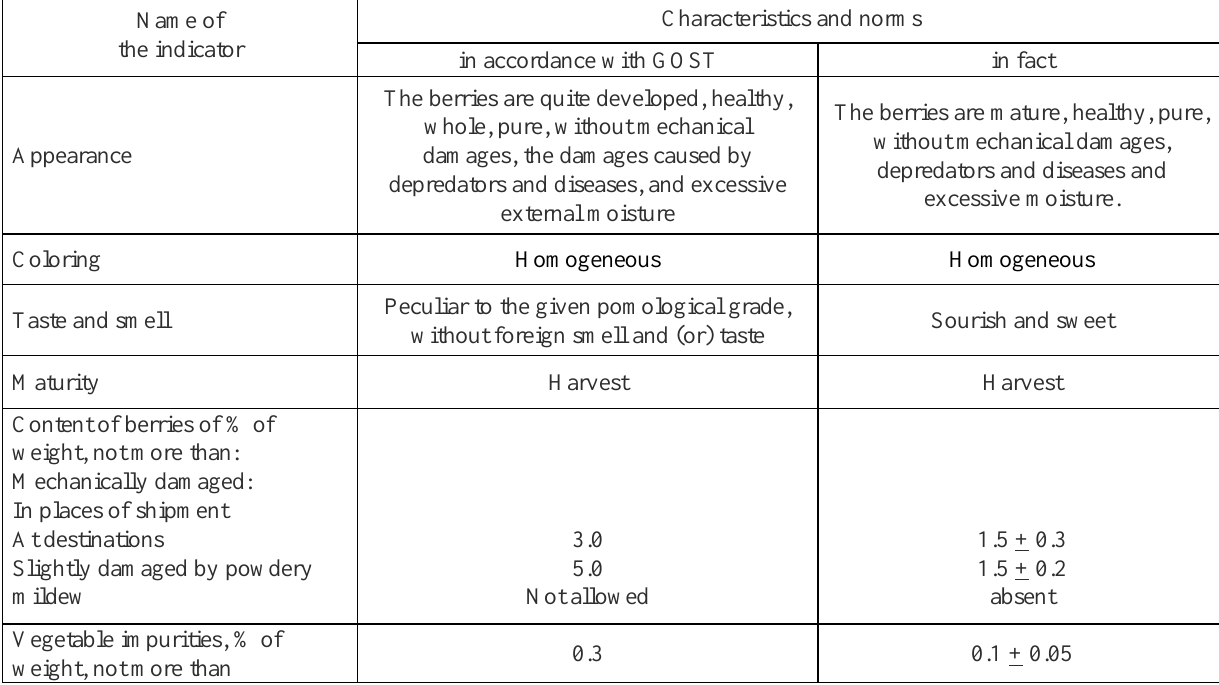
Table 6. Indicators of quality of fruits of Ríbesúva-críspa (garden gooseberry, the grade “Kooperator”), n = 5